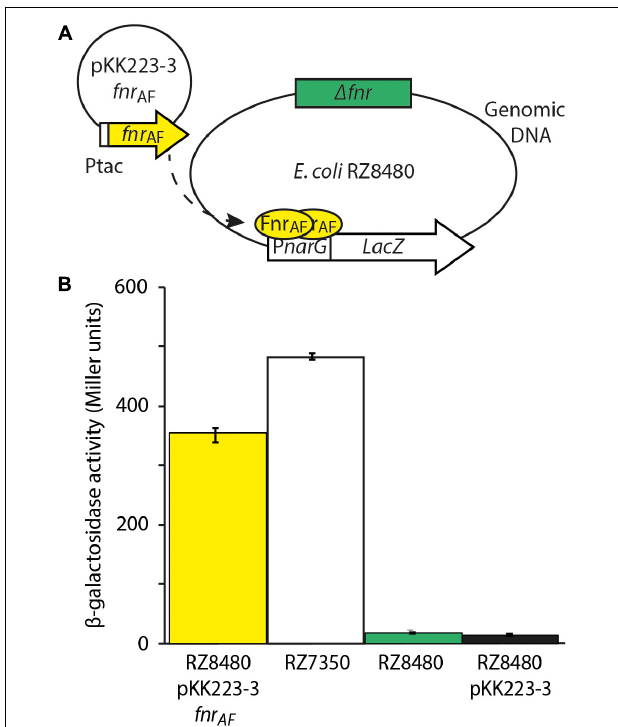
FIGURE 3 | Experimental design and results of FNR AF activity from the Escherichia coli promoter P nar G. (A) Experimental design to test the effect of FNR AF (encoded on plasmid pKK223-3 fnr AF ) on in vivo expression of P nar G in E. coli (cid:49) fnr . (B) Data are reported as β -galactosidase activities ( n = 3 ± SD, one way Anova p < 0.05) in strains RZ8480 A. f. [ E. coli fnr ( − ) fnr A,f. ( + )] in plasmid pKK223-3, PK7350 [ E. coli fnr ( + )], RZ8480 [ E. coli fnr ( − )], and RZ8480 PKK [ E. coli fnr (–)] with pKK223-3 plasmid. The dotted arrow indicates the expression of FNR AF from fnr AF , its dimerization and binding to P nar G.